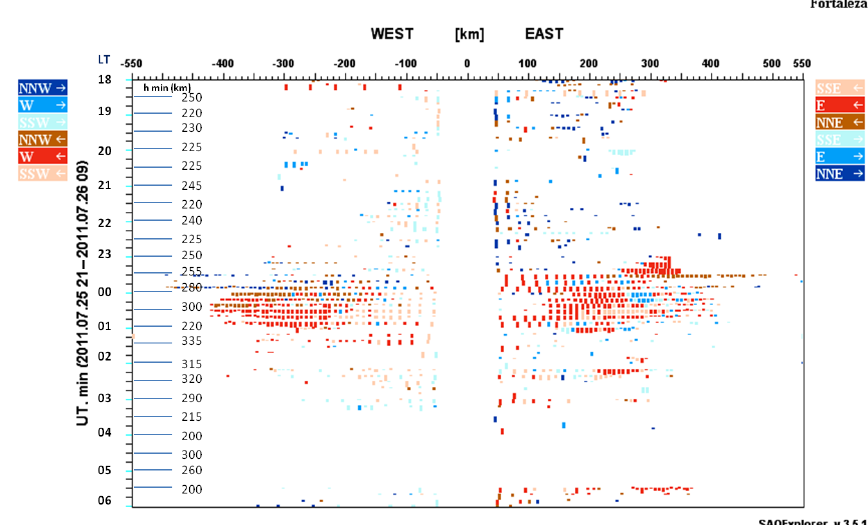
Figure 5. Directogram for Fortaleza on 26 July showing the location and the horizontal distances of the irregularities detected by digisonde and seen in the ionograms as spread F. At left is the F-region height (km), where h min is the spread-F reflection height. Color code with arrows indicates the direction from which the irregularities are coming or to which the irregularities are